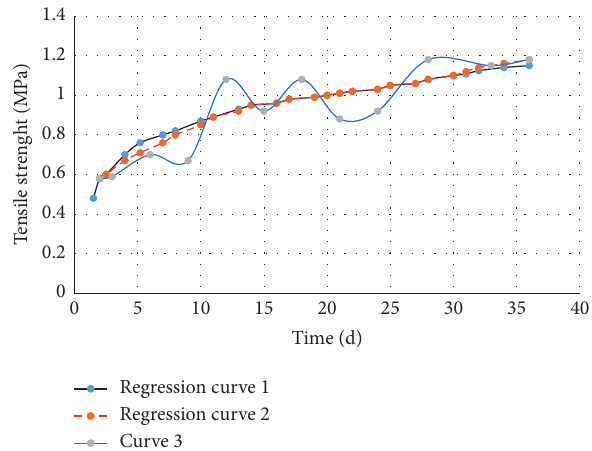
Figure 7: Curves of paste-filling tensile strength changing with time.